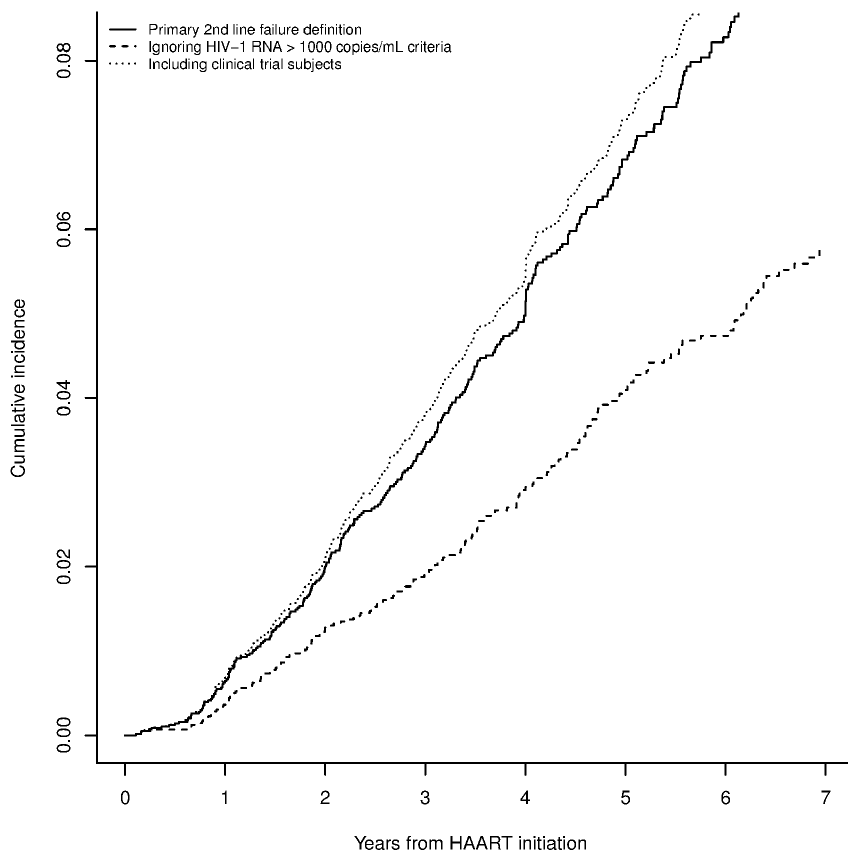
Figure 1. Cumulative incidence after HAART initiation of starting a third line regimen or failing a second line regimen.